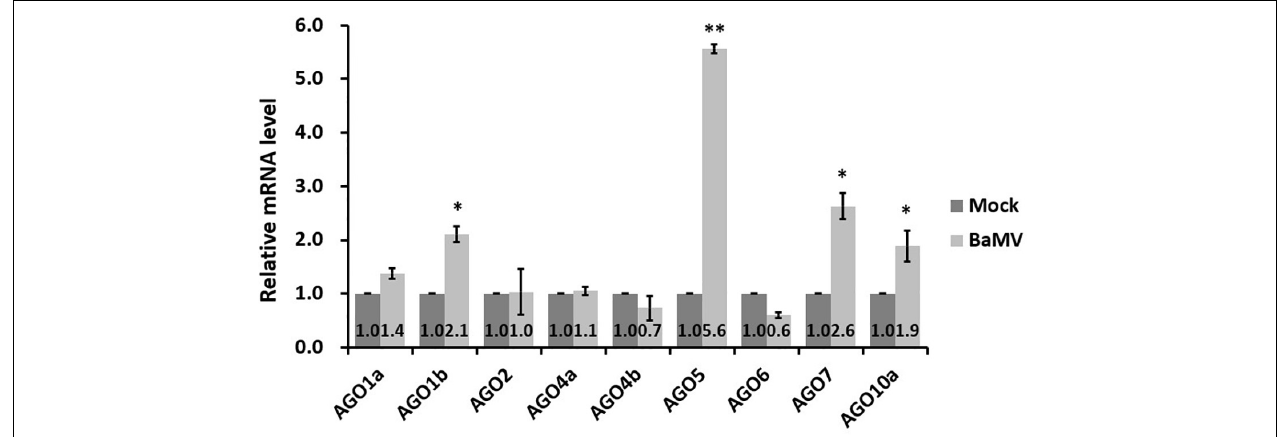
FIGURE 2 | Realtime RT-PCR analyzes of Argonaute genes in Bamboo mosaic virus (BaMV)-inoculated Nicotiana benthamiana . Nicotiana benthamiana leaves were mechanically inoculated with 0.5 µ g of BaMV virions and then collected at 5 dpi for analysis. Real-time quantitative reverse transcription PCR (qRT-PCR) was used to determine the relative expression of Argonautes mRNAs in inoculated leaves, with actin serving as an internal control. Each column represents the average of at least three replicates ± standard error (SE). Statistical significance was analyzed using two-tailed student’s t -tests; * p < 0.05; ** P < 0.01.